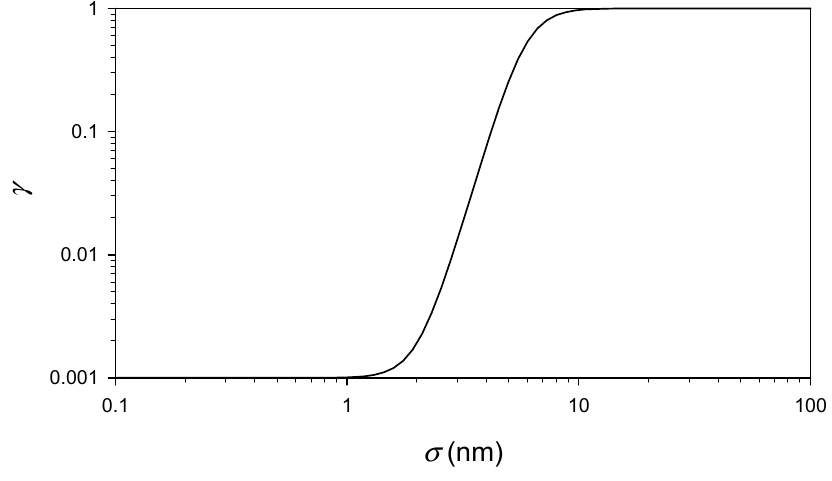
Figure 1. Collision efficiency as a function of the collision diameter of the soot particle.